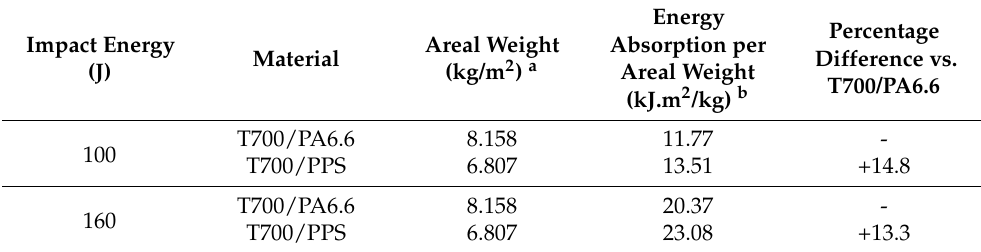
Table 3. Summary of the LVI performance of the different composite systems relative to the T700/PA6.6 system.